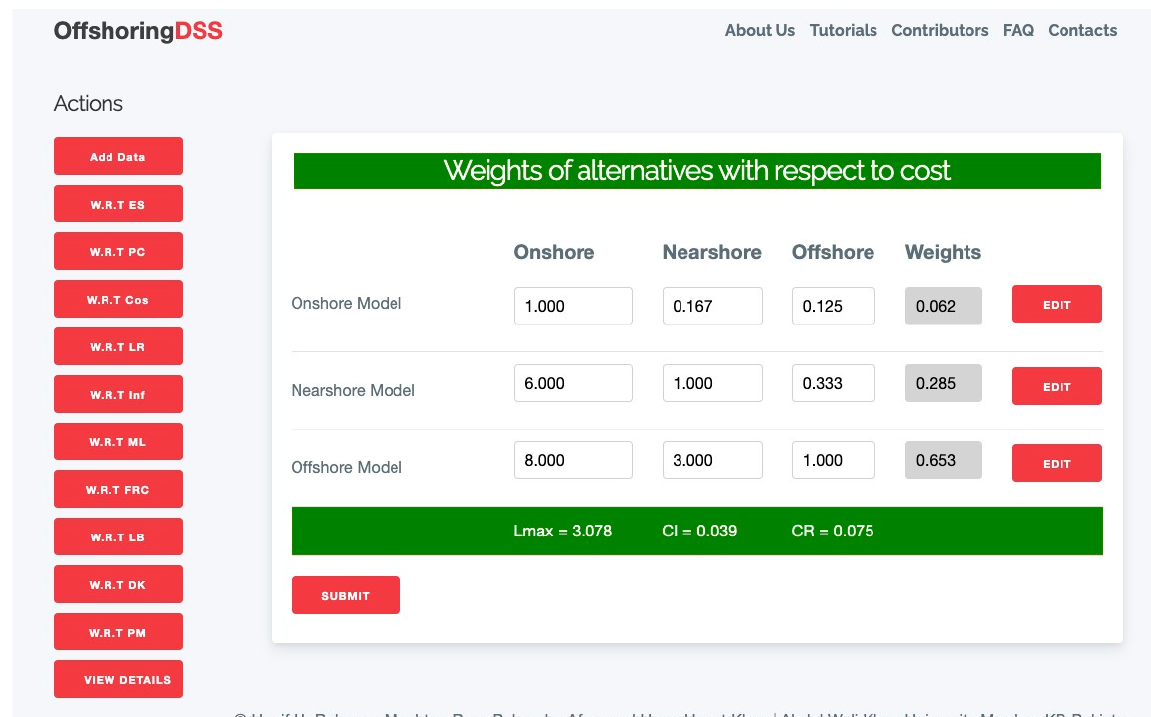
Figure A1. Alternatives weights with reference to PC and CR.